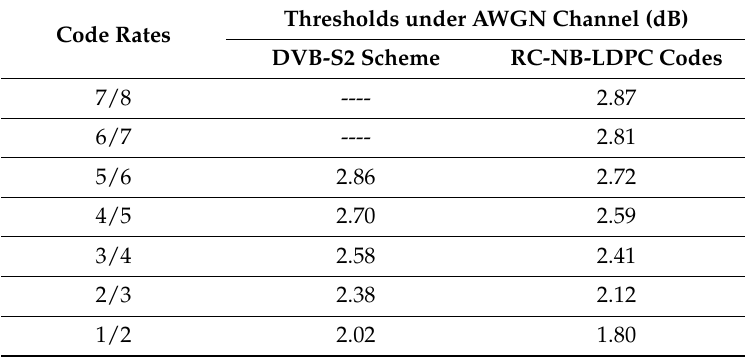
Figure 14. EXIT chart of the designed degree distributions. Table 4. Threshold Predictions of Designed